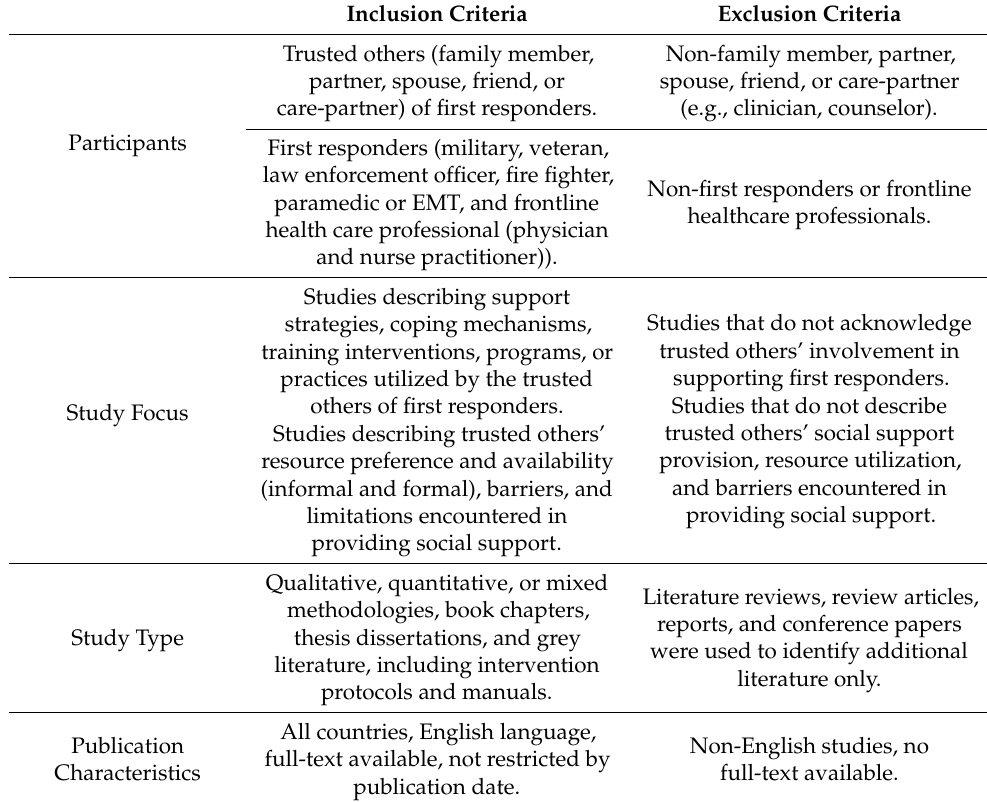
Table 1. Inclusion and exclusion